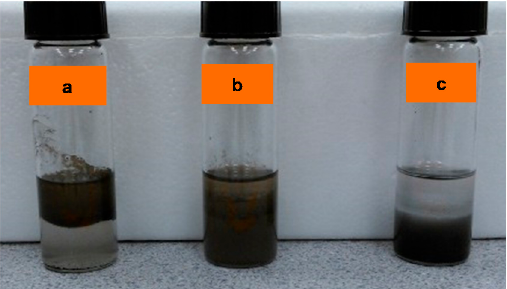
Figure 3. The visual appearance of 0.02 g GO with different modifiers in the MMA/water (50/50 v/v) mixture, 10-minute sitting after sonication, ( a ) VBTAC, ( b ) SDBS, ( c ) QAL.